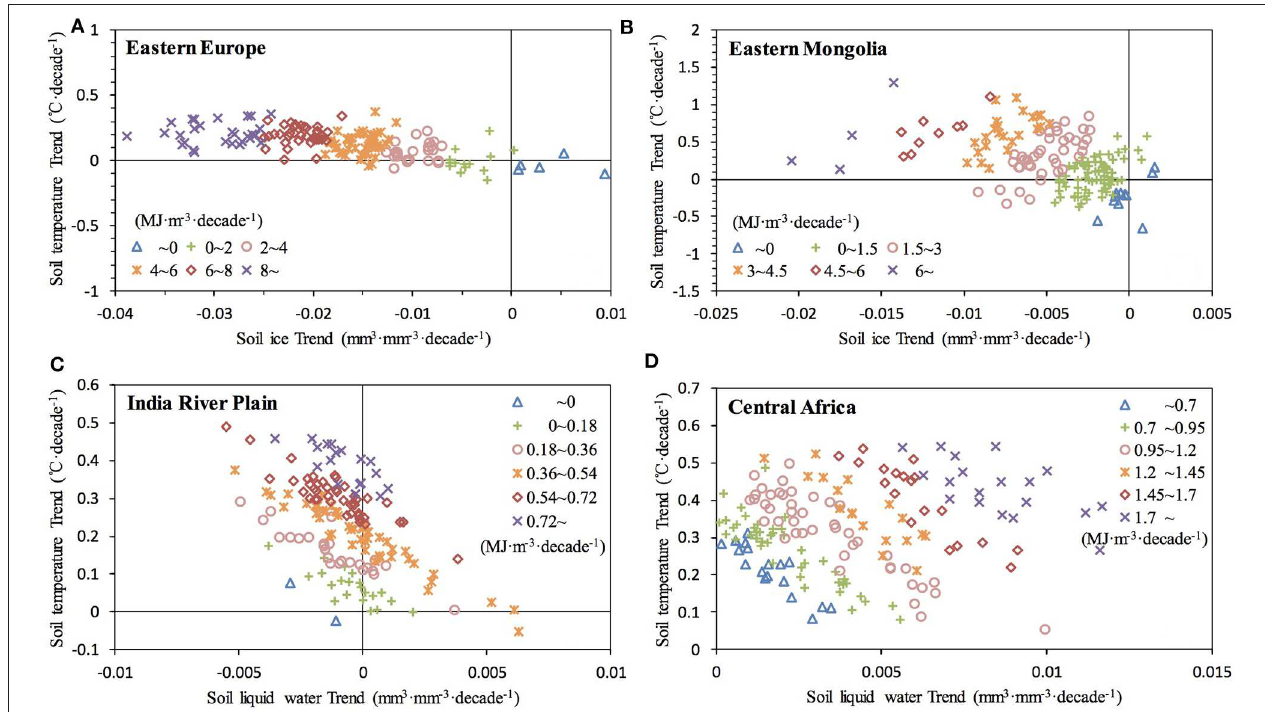
FIGURE 5 | Trends of soil enthalpy vs. soil ice/liquid water and soil temperature trends over (A) Eastern Europe (EE), (B ) Eastern Mongolia (EM), (C) India River Plain (IP), and (D) Central Africa